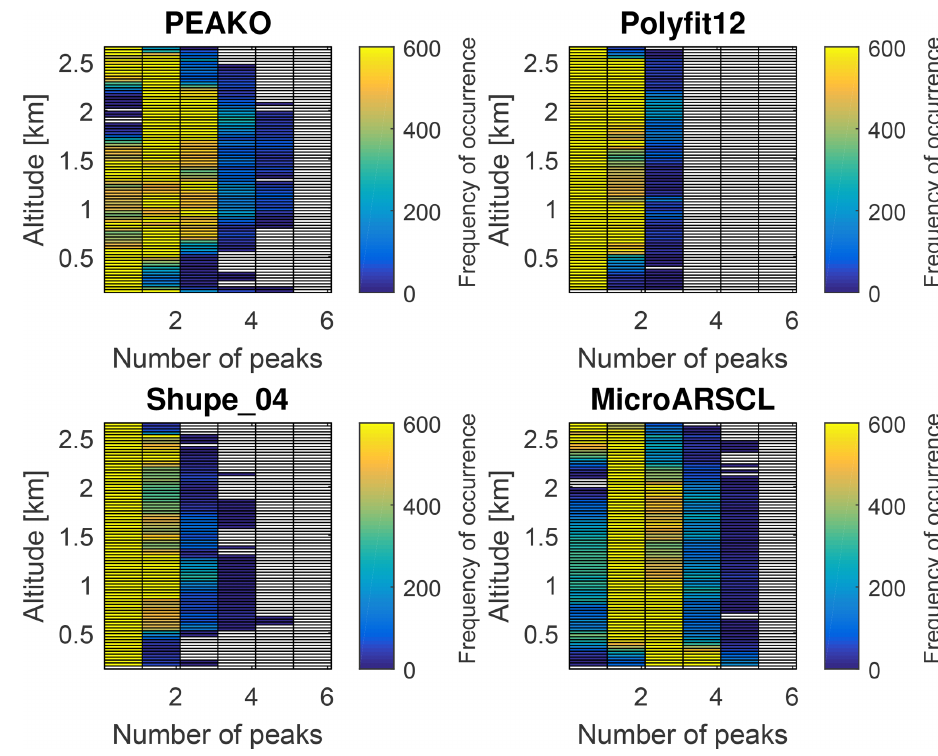
Figure 11. Like Fig. 6 but for the case study period on 2 February 2014, 16:00 to 17:00UTC, at 0 to 2.7km altitude.